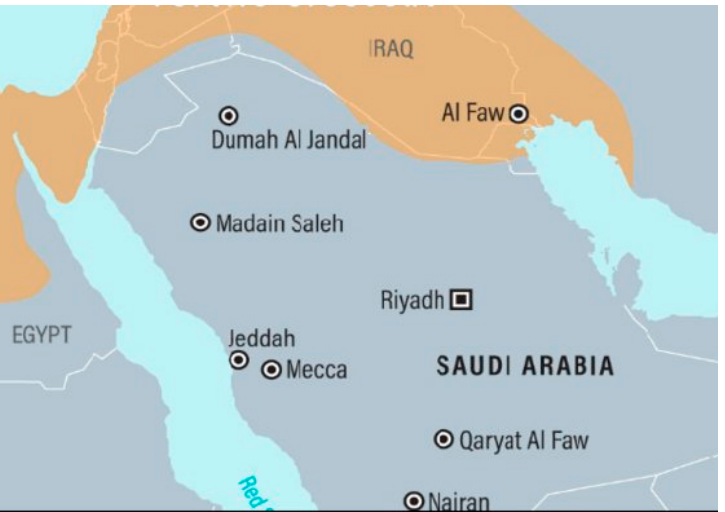
Figure 1. The location of the Dumah AlJandal site within a map of Saudi Arabia [31]. Reproduced from [31], Horizon Research Publishing: 2021.